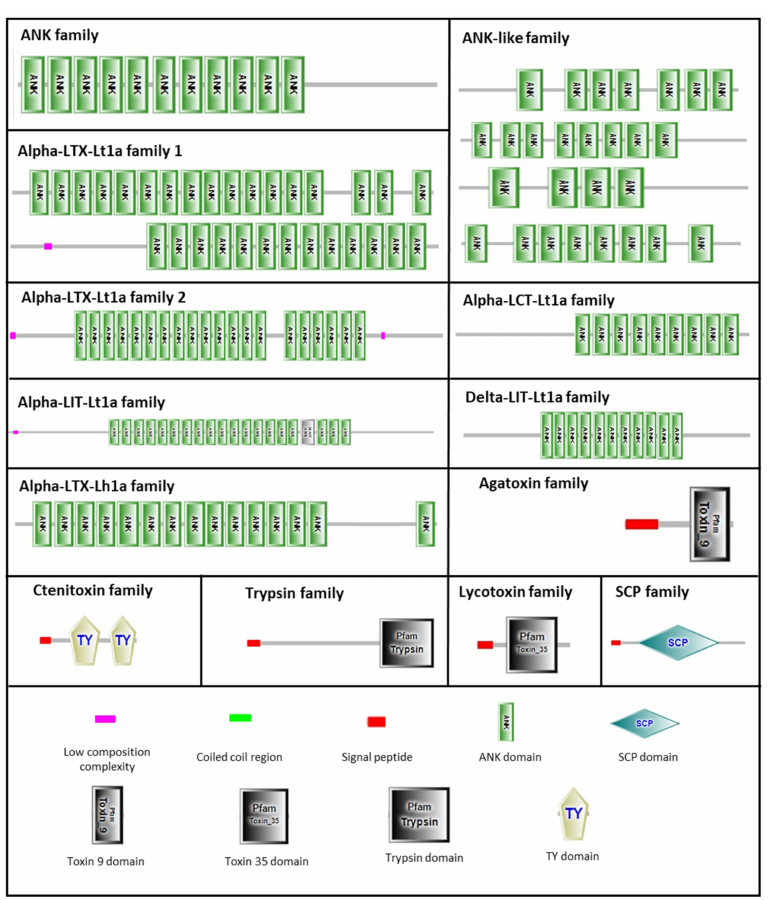
Figure 7. Domain architecture of Latrodectus geometricus toxins was predicted by the simple modular architecture research tool (SMART) and the protein family database (Pfam) servers (http://www. smart.embl-heidelberg.de, accessed on 4 April 2021 and http://pfam.janelia.org, accessed